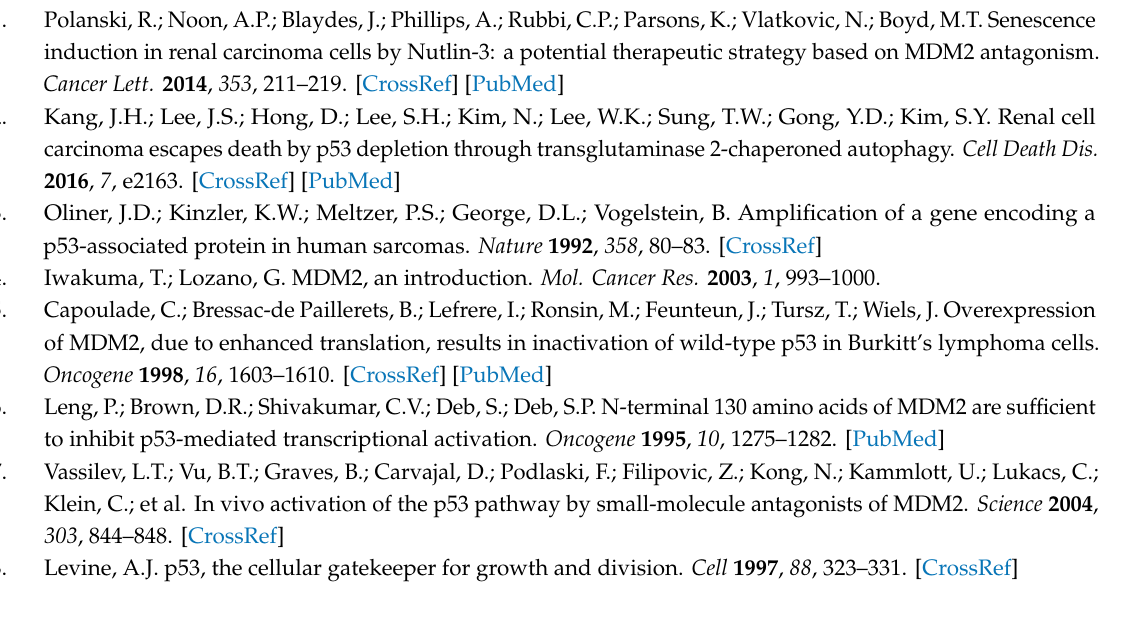
Figure S1: Knock down of TGM2 and MDM2 stabilized p53 in RCC under normoxic condition; Figure S2: Inhibition of TGase 2 and MDM2 stabilized p53 in RCC under normoxic condition; Figure S3: Immunohistochemistry of tumors from human RCC xenograft test with inhibition of TGase 2 and MDM2; Figure S4: TGase 2 was induced after MDM2 inhibition; Table S1, the anticancer e ff ects of inhibition of TGase 2 and MDM2 in ACHN xenograft